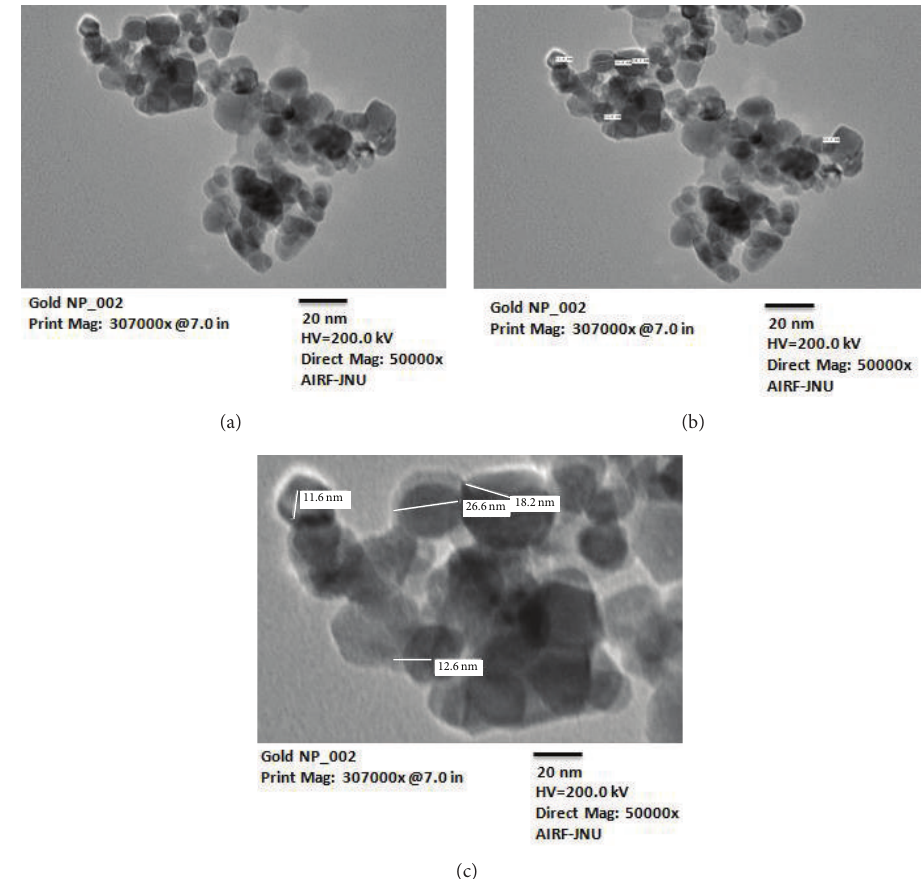
Figure 1: Transmission electron microscopy (TEM) of gold nanoparticles. (a) Aggregates of gold nanoparticles, (b) dimensions of a tuft of nanoparticles, and (c) enlarged image for size analysis.